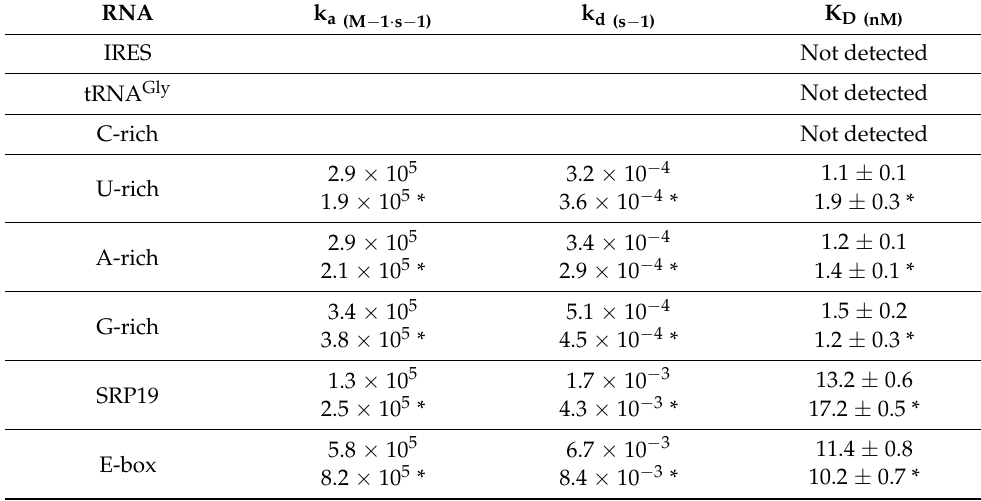
Table 1. Kinetic constants and equilibrium dissociation constants (K D ) of the NUCB1-RNA complexes in the presence or absence (*) of Ca 2+